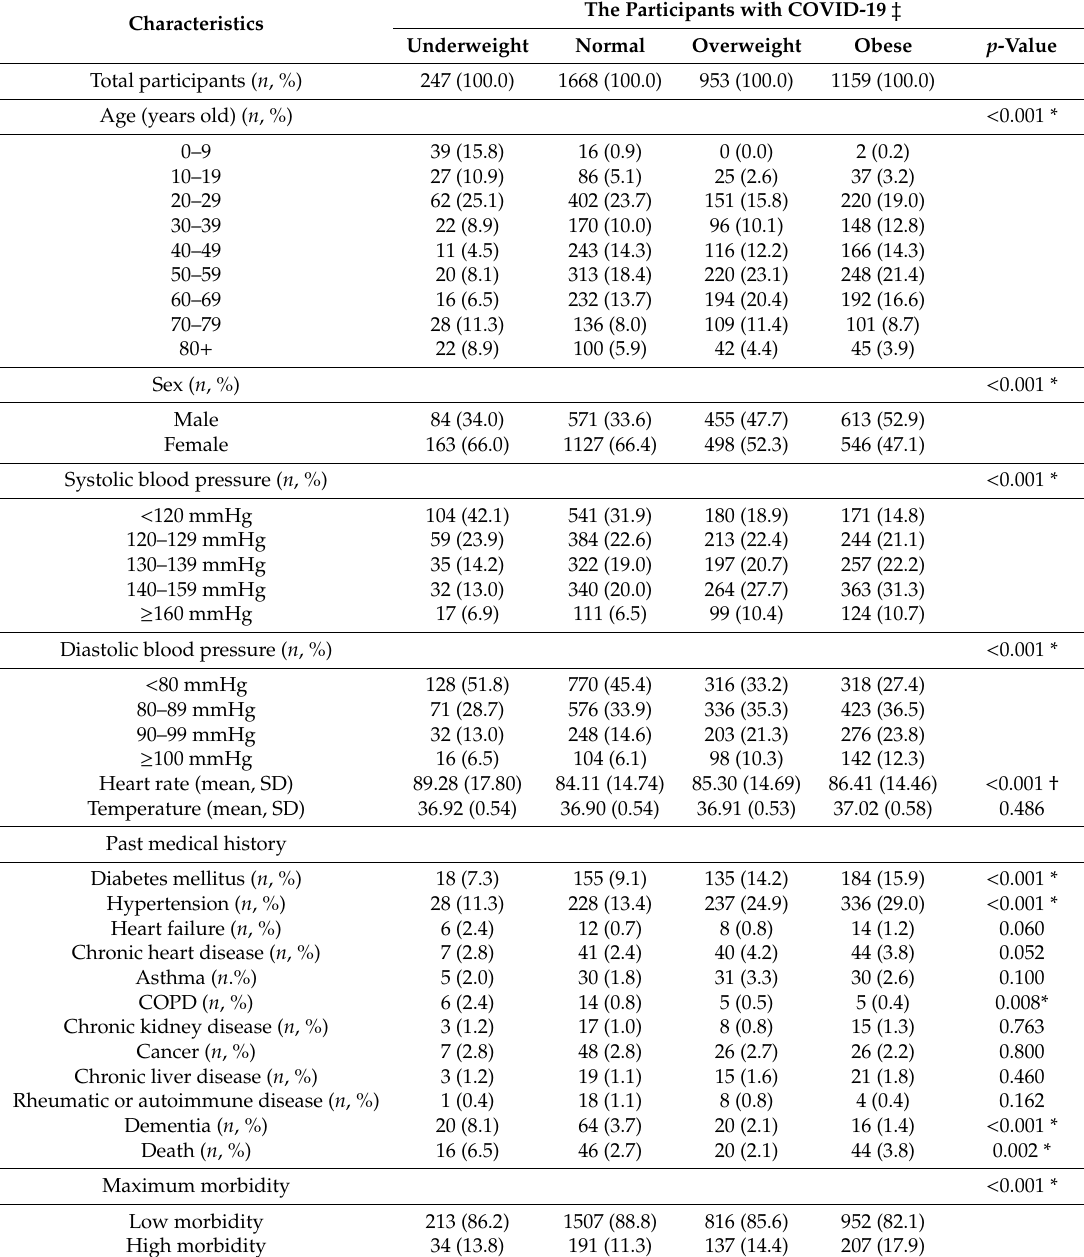
Table 1. General characteristics of the participants with COVID-19 according to obesity.